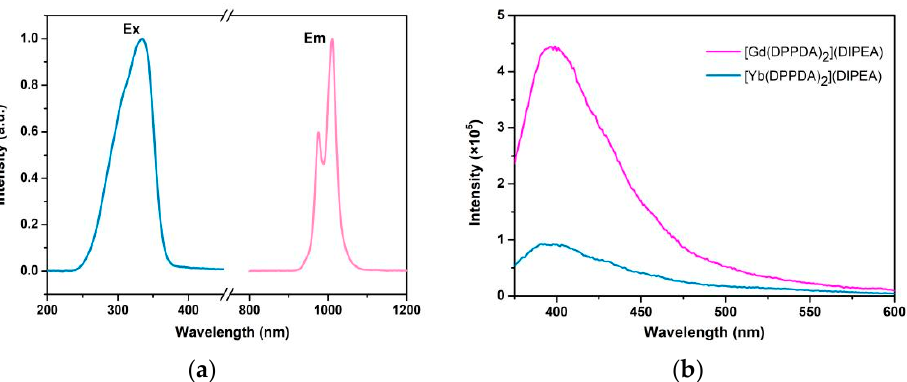
Figure 4. ( a ) Excitation and emission spectra of [Yb(DPPDA) 2 ](DIPEA) (in 1.1 × 10 − 4 mol/L CHCl 3 solution) at room temperature. ( b ) UV-Vis emission spectra of [Gd(DPPDA) 2 ](DIPEA) and [Yb(DPPDA) 2 ](DIPEA) (in 1.1 × 10 − 4 mol/L CHCl 3 solution, λ ex = 348 nm) at room temperature.